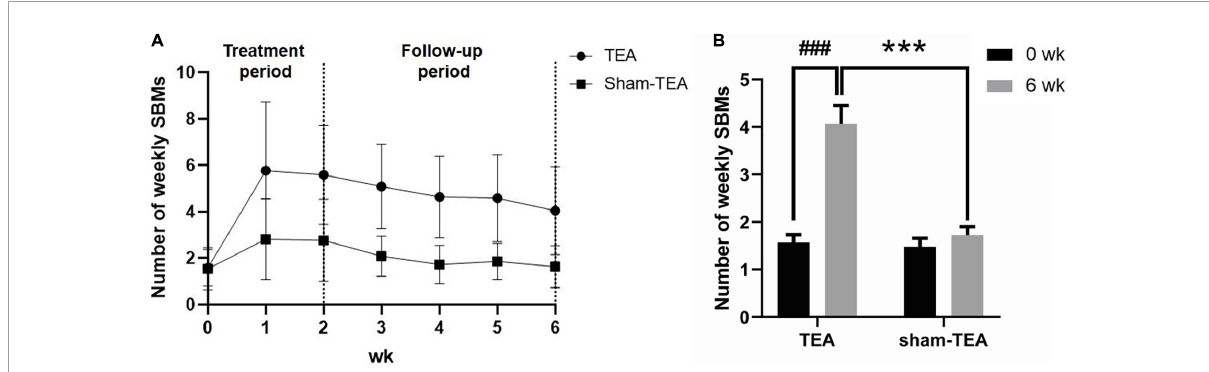
FIGURE3 The sustained effect of TEA on the improvement of patients’ weekly SBMs. Weekly SBMs in the TEA group and sham-TEA group during the study (A) . Weekly SBMs in the TEA group and sham-TEA group at 6 weeks after treatment (B) (vs baseline, ### P < 0.001; vs sham-TEA, *** P < 0.001).